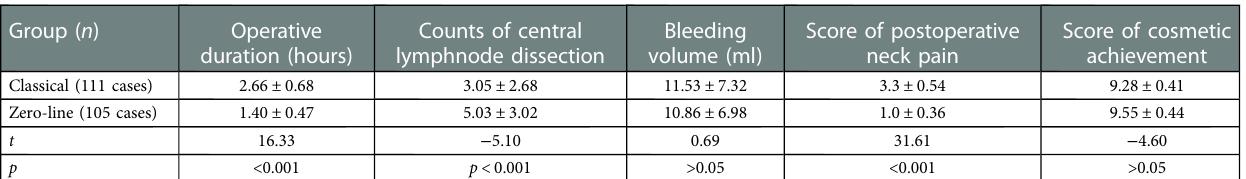
TABLE 2 Operative indicators of two